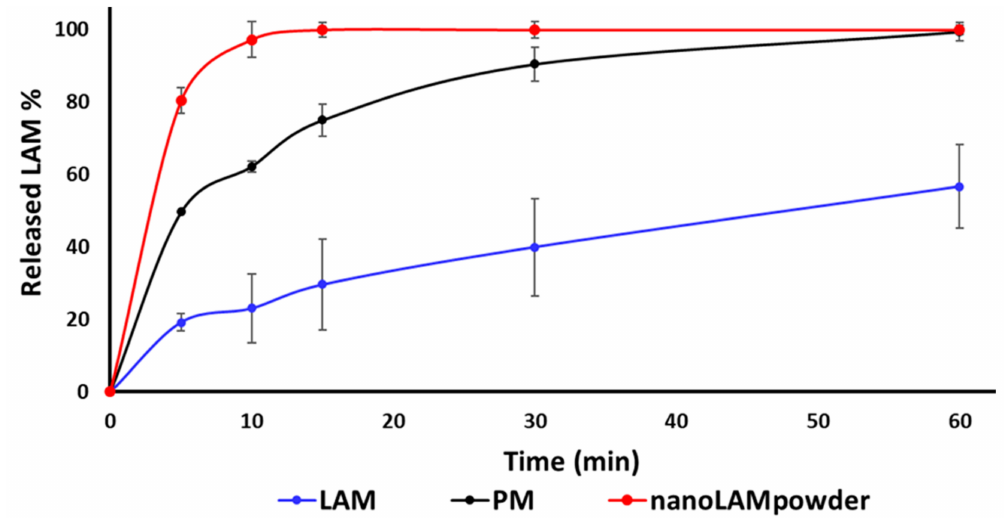
Figure 4. In vitro dissolution study of the samples in pH 5.60 bu ff er at 30 ◦ C.